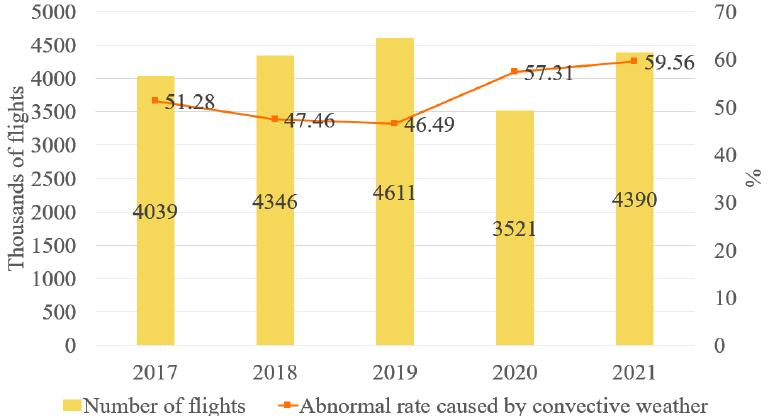
Figure 1. Number of flights and abnormal rate caused by convective weather from 2016 to 2020.